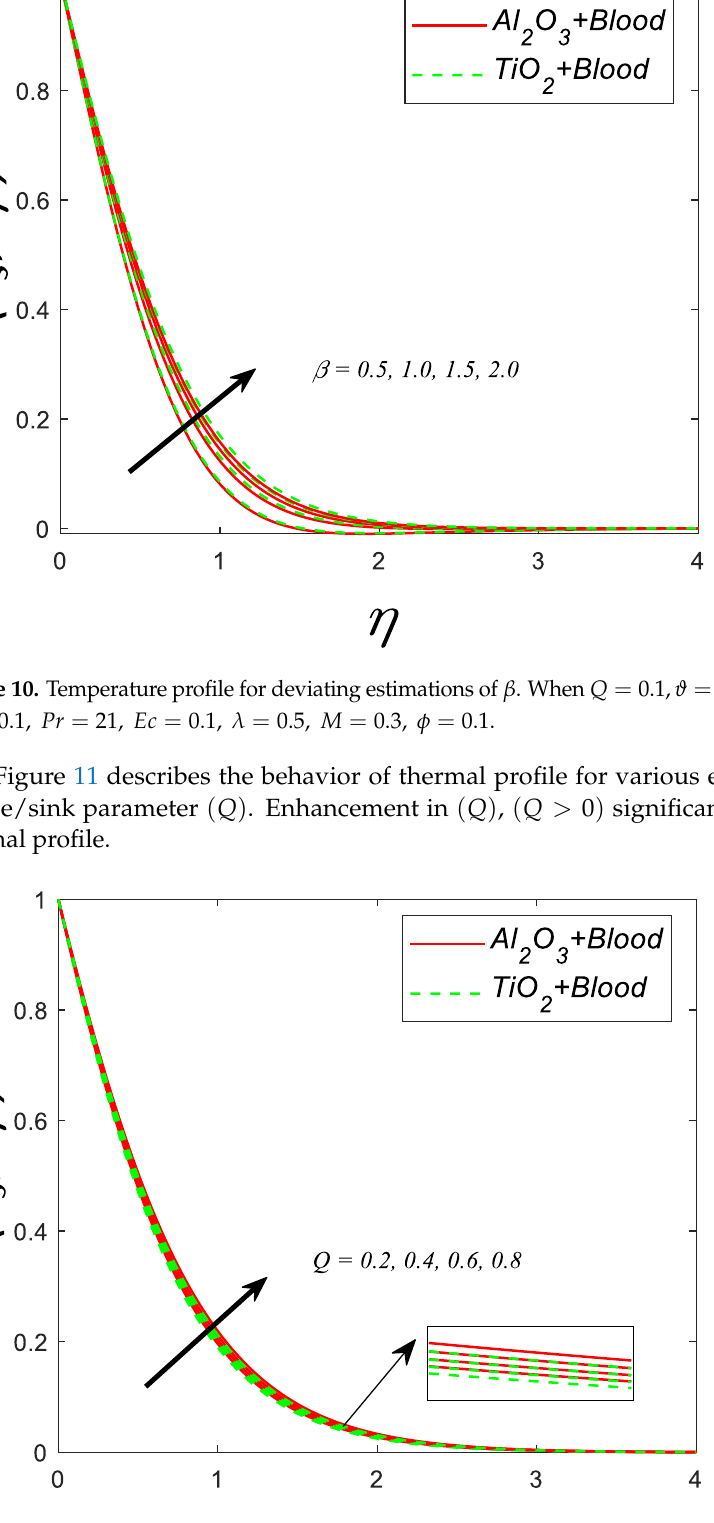
Figure 11. Temperature profile for deviating estimations of 𝑄 . When 𝑄 = 0.1,𝜗 = 𝜋 0.1,𝐺𝑟 = 0.1, 𝑃𝑟 = 21,𝐸𝑐 = 0.1, 𝜆 = 0.5,𝛽 = 1.5, 𝜙 = 0.1 .